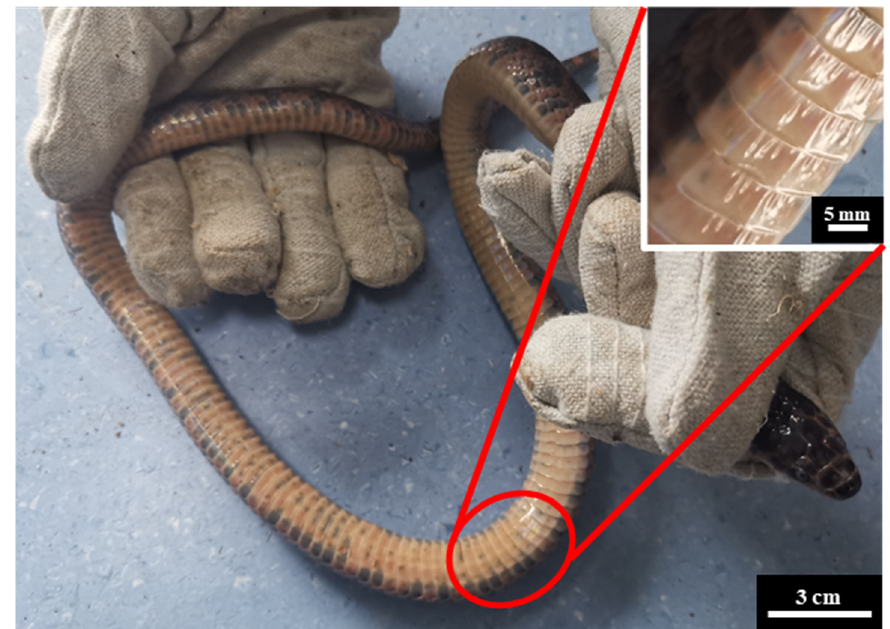
Figure 1. D. rufozonatum and ventral scales.